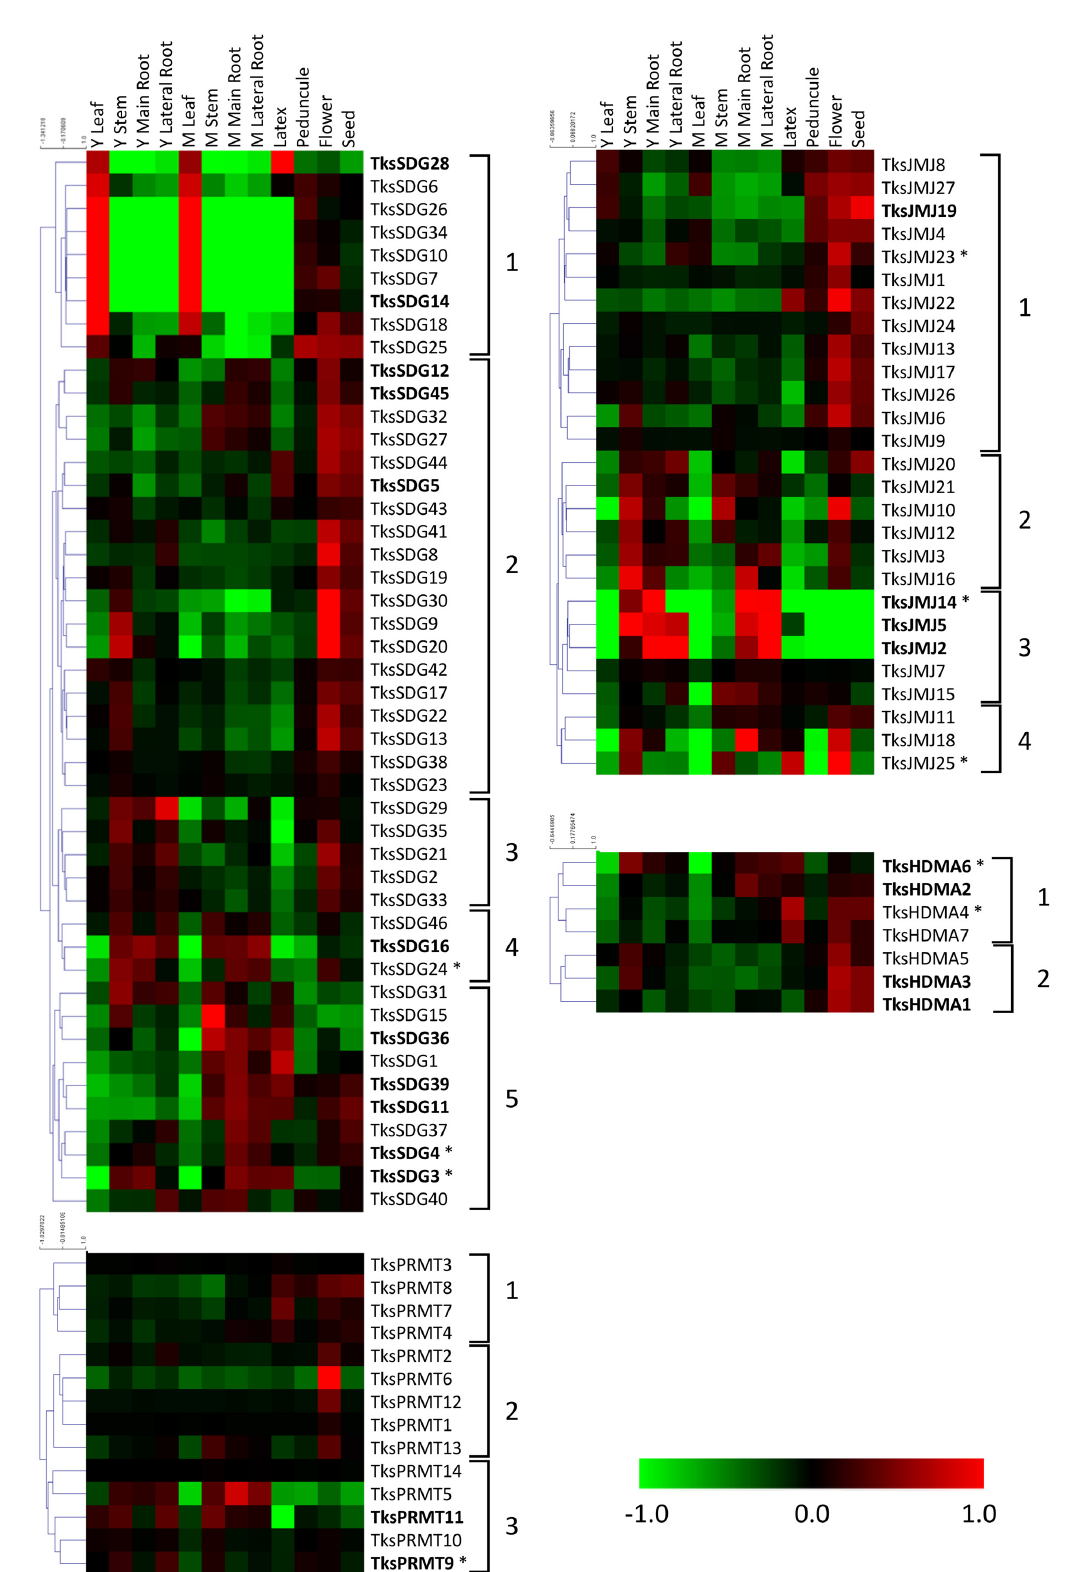
Figure 5. Heat map of Tks HMTs and Tks HDMs in different organs and developmental stages. The main clusters are indicated by square brackets. Genes with higher expression are indicated in bold. Asterisks indicate the genes analyzed by